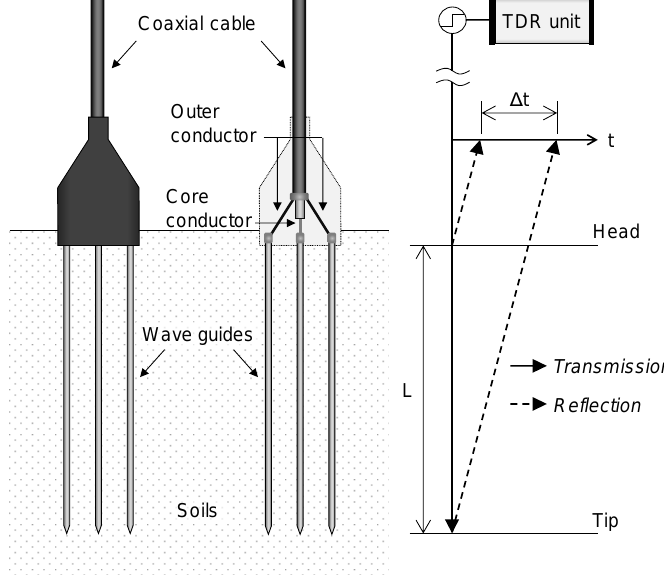
Figure 1. Time domain reflectometry (TDR) probe with three wave guides and propagation of the electromagnetic wave.